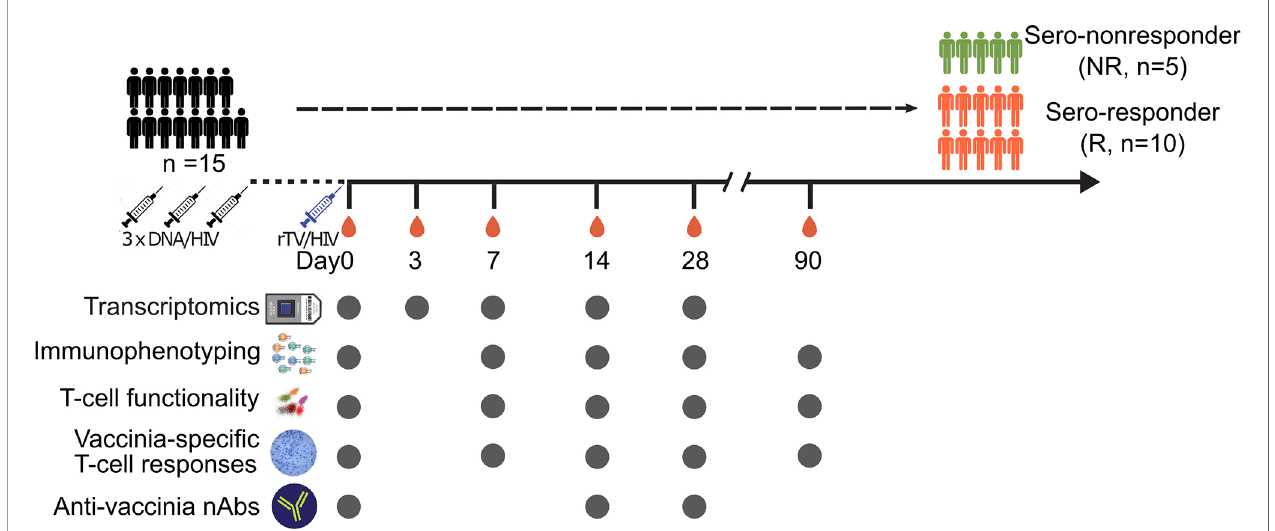
FIGURE 1 | Vaccination schedule and sampling scheme. Schematic diagram of the vaccinations and sample collection. Fifteen subjects participated in this sub- study. All participants were given three DNA/HIV-1 vaccine primes at weeks 0, 4, and 8, followed by a recombinant Tiantan vaccinia-based HIV-1 vaccine (rTV/HIV-1) booster, at 6 months post-last DNA/HIV-1 vaccine prime. Peripheral blood mononuclear cells and serum samples were taken on day 0 prior to the rTV/HIV-1 immunization and then again on days 3, 7, 14, 28, and 90 post-rTV/HIV-1 booster vaccination. Filled circles indicate the data collection time